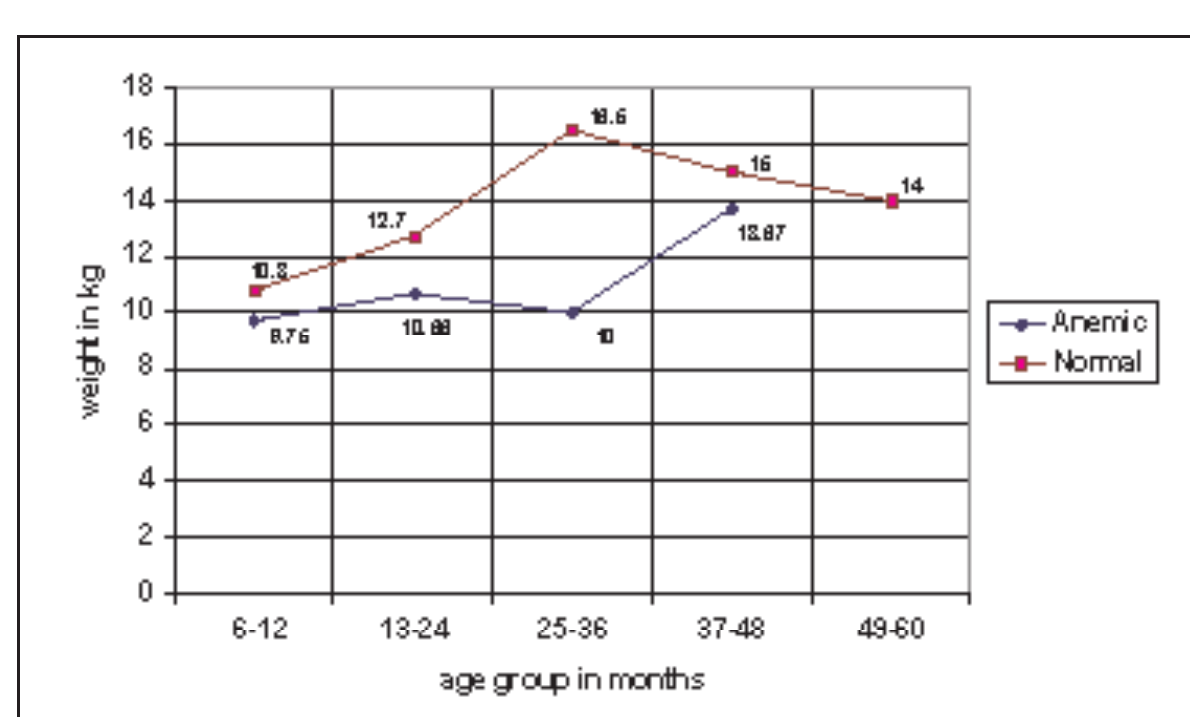
Fig. 4: Average Wt. of anemic vs normal children